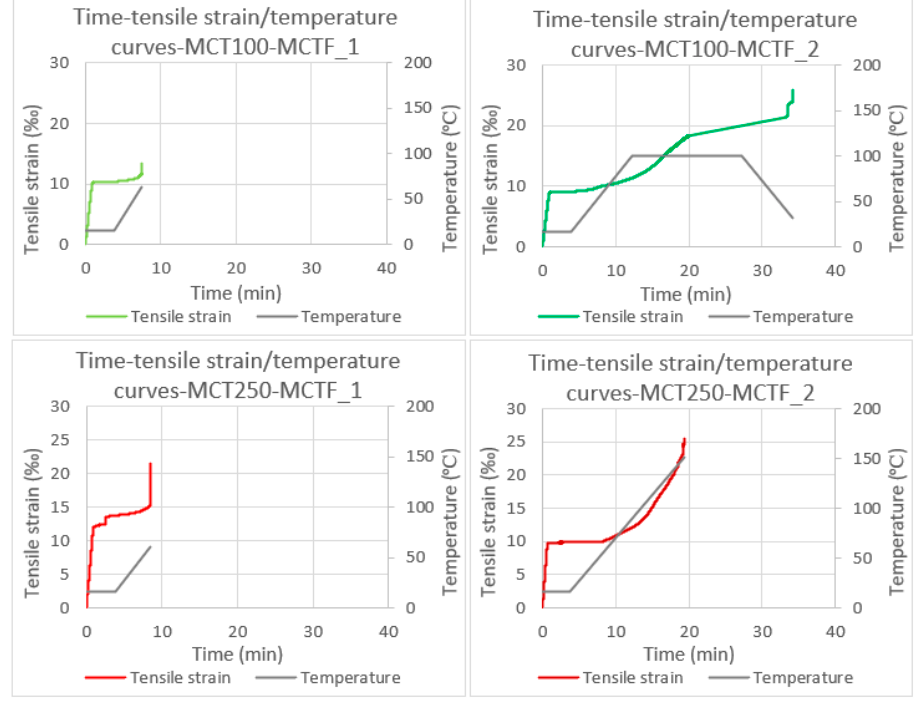
Figure 19. Time–strain/temperature curves of MCT100-MCTF_1-2 and MCT250-MCTF_1-2.